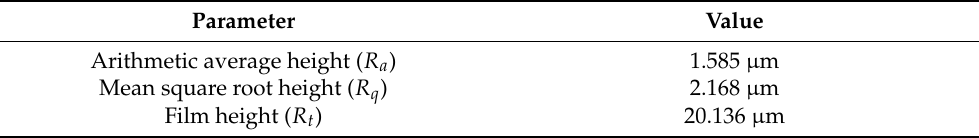
Table 2. Topological and surface roughness parameters of the gf